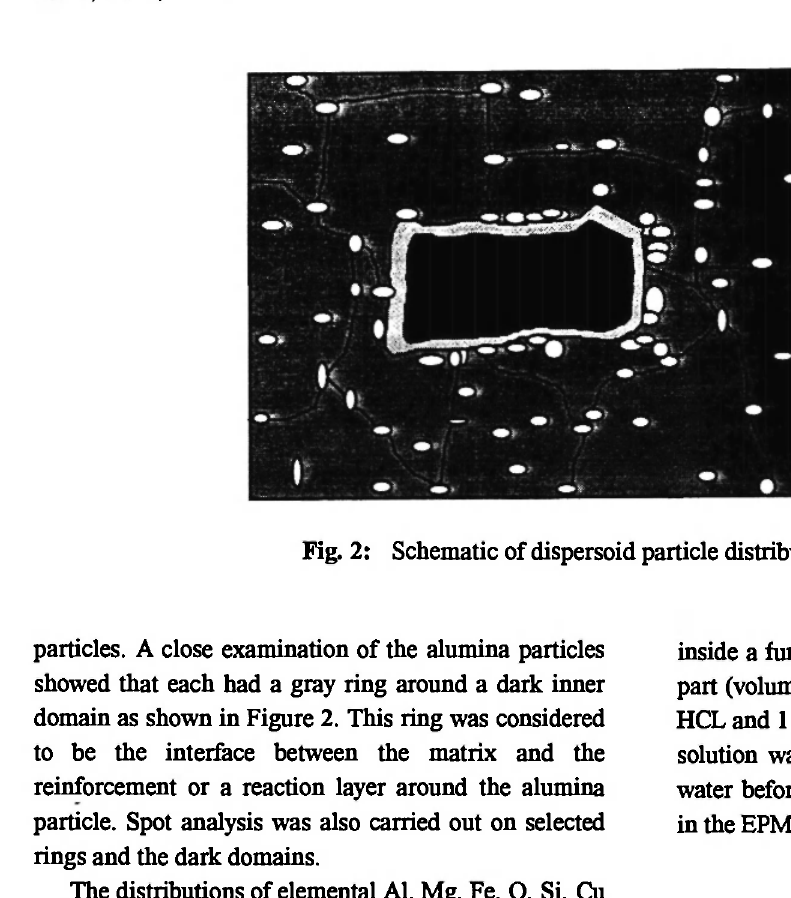
Fig. 2: Schematic of dispersoid particle distribution in the